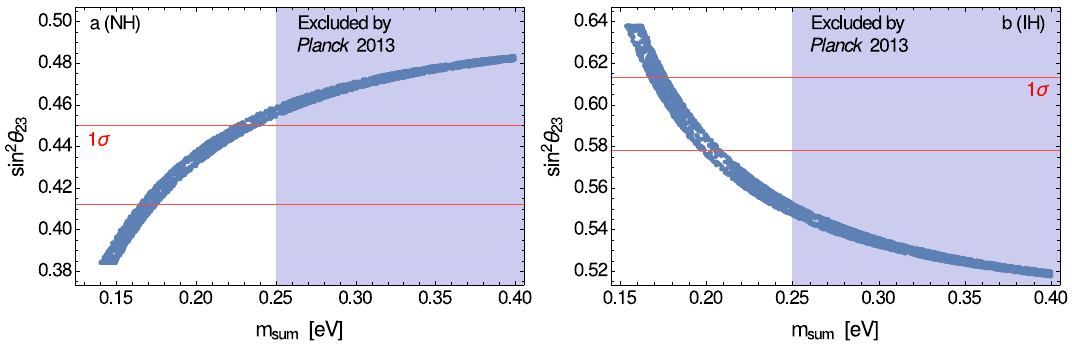
Figure 3 . Scatter plots of s 2 versus m sum following from the constraints (3.1). Figure 3a is for a 23 normal ordering of the neutrino masses and figure 3b is for an inverted